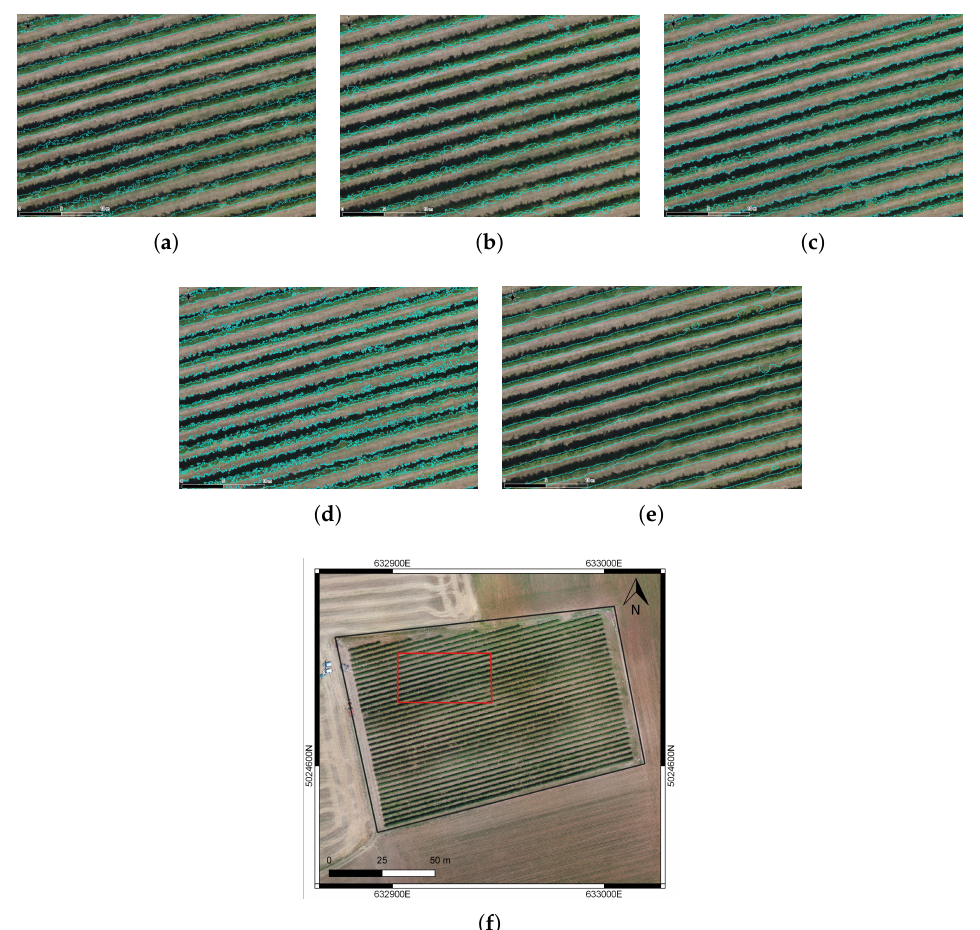
Figure 8. Vineyard site: crop row detection results for ( a ) local maxima extraction, ( b ) threshold selection, K-means clustering ( c ), MDM classifier ( d ), and the Bayesian segmentation ( e ). Figures refer to the area included in the red box in ( f